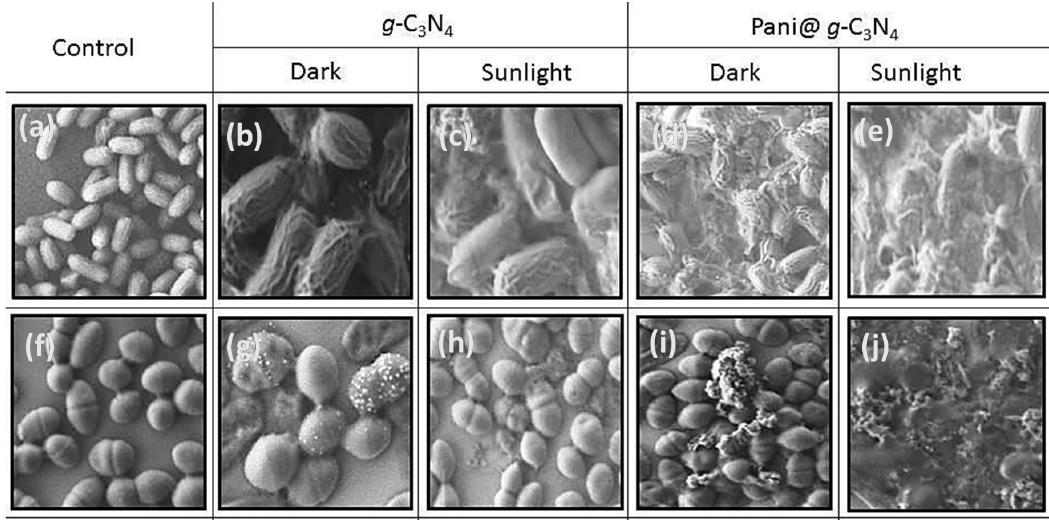
Figure 5. The effect of g-C 3 N 4 and Pani@g-C 3 N 4 on E. coli and S. pneumoniae cells structure in dark and sunlight. The micrographs labeled ( a ) and ( f ) are control E. coli and S. pneumoniae respectively; ( b ) and ( g ) are g-C 3 N 4 treated E. coli and S. pneumoniae in dark respectively; ( c ) and ( h ) are g-C 3 N 4 treated E. coli and S. pneumoniae in sunlight respectively; ( d ) and ( i ) are Pani@g-C 3 N 4 treated E. coli